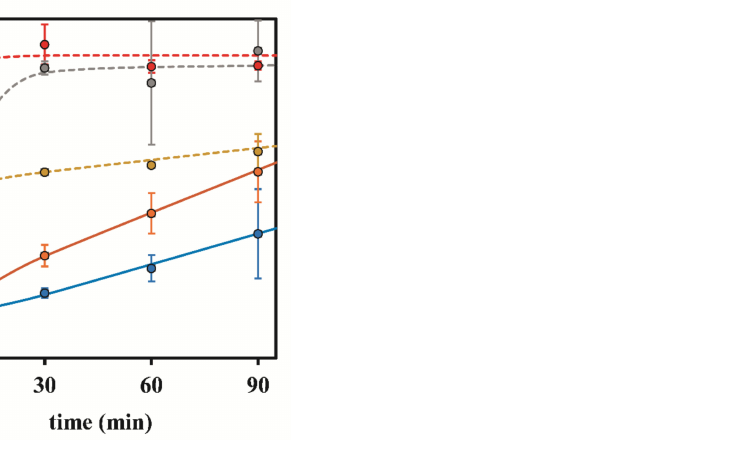
Figure 4. Influence of stirring and resin mass (Dowex 50W-X8 50–100 mesh) on the purification ratio (%) of AgNPs suspensions. • —0.25 g of resin, S-OFF; • —0.50 g of resin, S-OFF; • —0.25 g of resin, S-ON; • —0.50 g of resin, S-ON; • —1.00 g of resin, S-ON. The represented values are the average of three replicates for each different